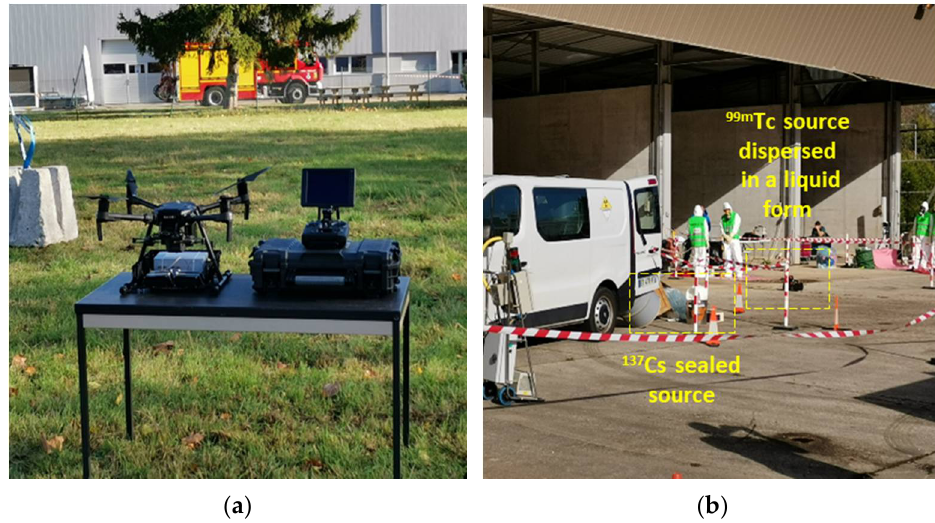
Figure 15. Detection system mounted under the UAV presented at CEA ( a ); radioactive contamination scenario ( b ).